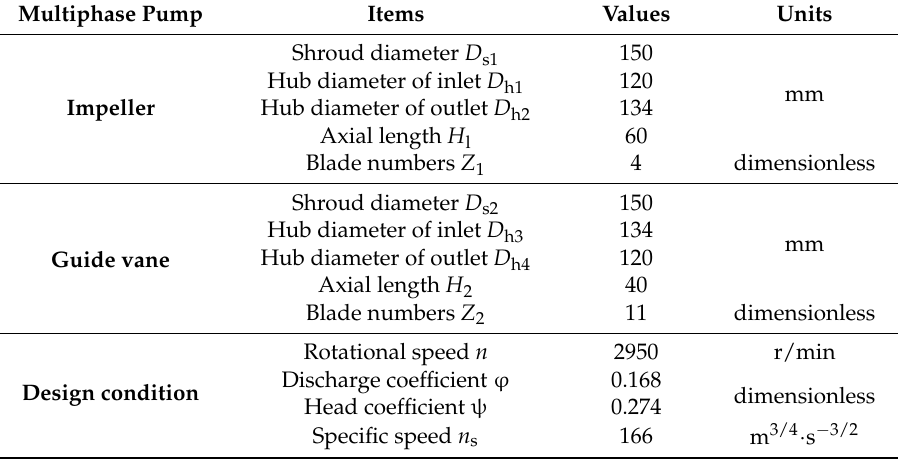
Table 1. The dimension and design details of the multiphase pump.